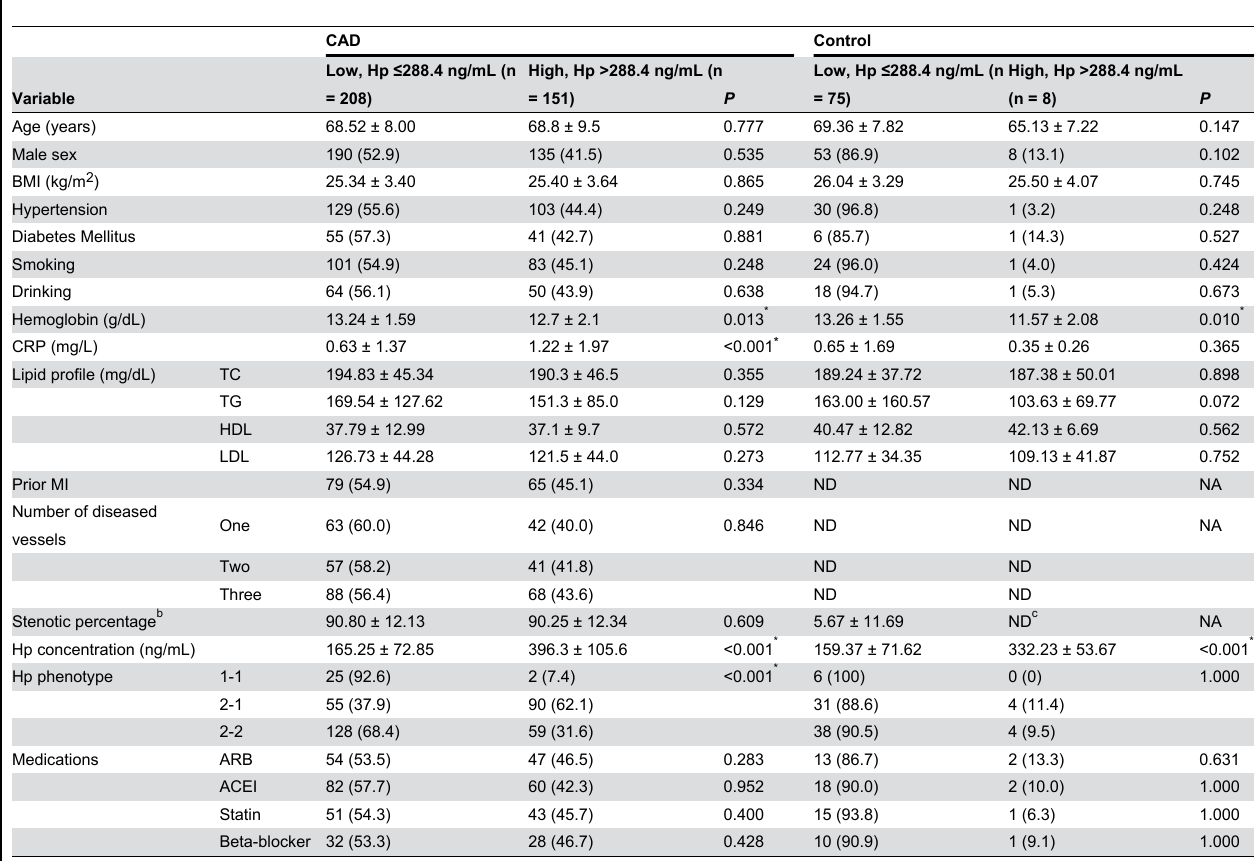
Table 2. Comparison of participants’ characteristics by coronary artery disease status and haptoglobin concentration (low or